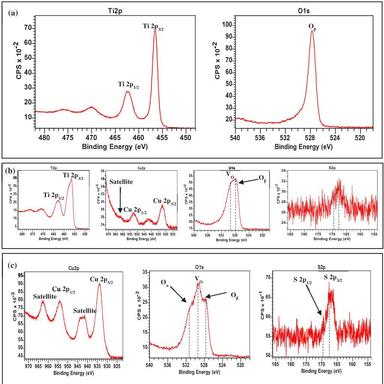
High resolution-XPS spectra: (a) TC0 (Ti2p and O1s); (b) TC2 (Ti2p, Cu2p, O1s and S2p); (c) TC7 (Cu2p, O1s and S2p).